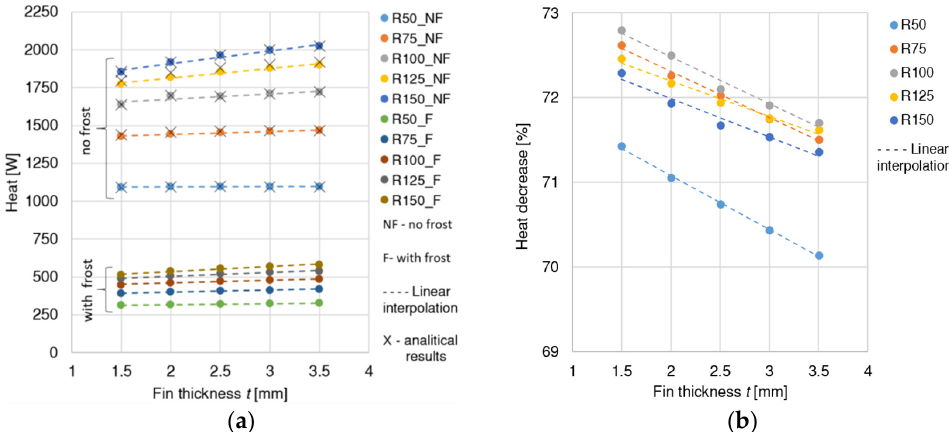
Figure 17. ( a ) Heat transferred through the 1 m length of the finned tube with 12 fins, ( b ) Heat decrease due to frosting.